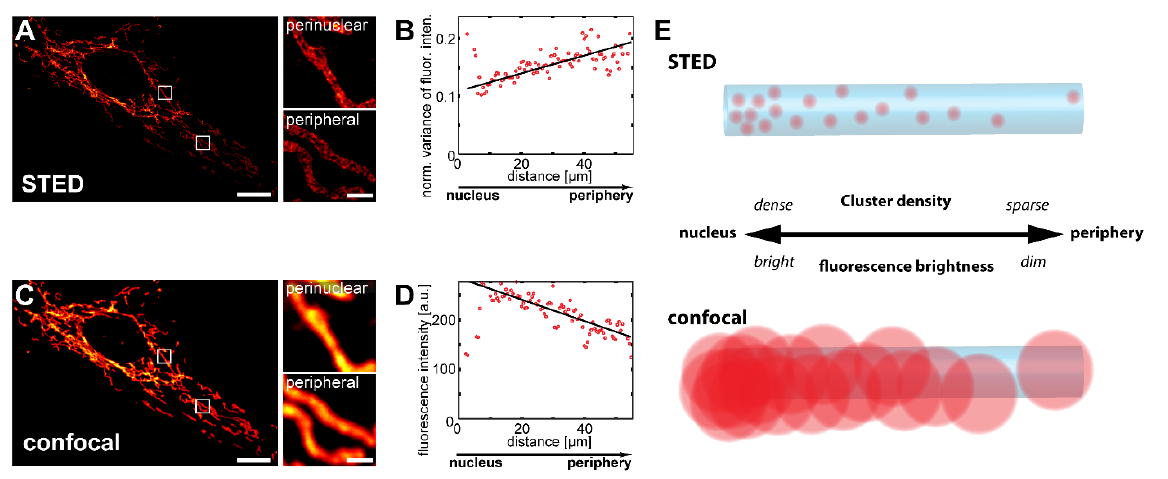
Figure 1. Tom20 forms an inner-cellular abundance gradient, which can be detected with confocal microscopy. ( A – D ) STED super-resolution and diffraction-limited confocal microscopy reveal inner-cellular Tom20 abundance gradients. Vero cells were decorated with antiserum against Tom20 and imaged by STED ( A ) or confocal ( C ) microscopy. Small images are magnifications of perinuclear or peripheral mitochondria, as indicated by rectangles in the corresponding overview images. Analysis of inner-cellular Tom20 abundance gradients using the STED ( B ) and the confocal ( D ) image data. Plotted are the averaged normalized local variance values of the fluorescence intensity ( B ) or the averaged fluorescence intensity values ( D ), each from the center of the cell, as shown in ( A , C ), to its periphery. Schematic showing the effect of abundance gradients of mitochondrial proteins on the appearance in images recorded with STED and confocal microscopy ( E ). Scale bars: 1 µm (magnifications), 10 µm (overviews).